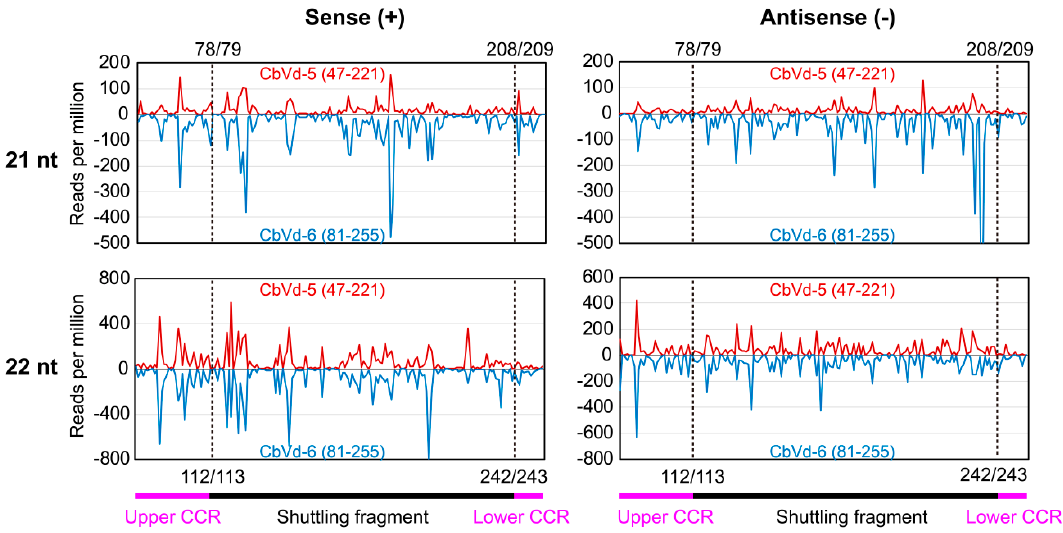
Figure 4. Distribution of sRNAs (21 and 22 nt) on the genomic fragment shared by CbVd-5 and -6. Sense strand is indicated in red and antisense strand in blue. Locations of CCR and shuttling fragment on CbVd-5 and -6 genomes are 47–221 and 81–255, respectively. A dashed line indicates the boundary between shuttling fragment and CCR (upper and lower).